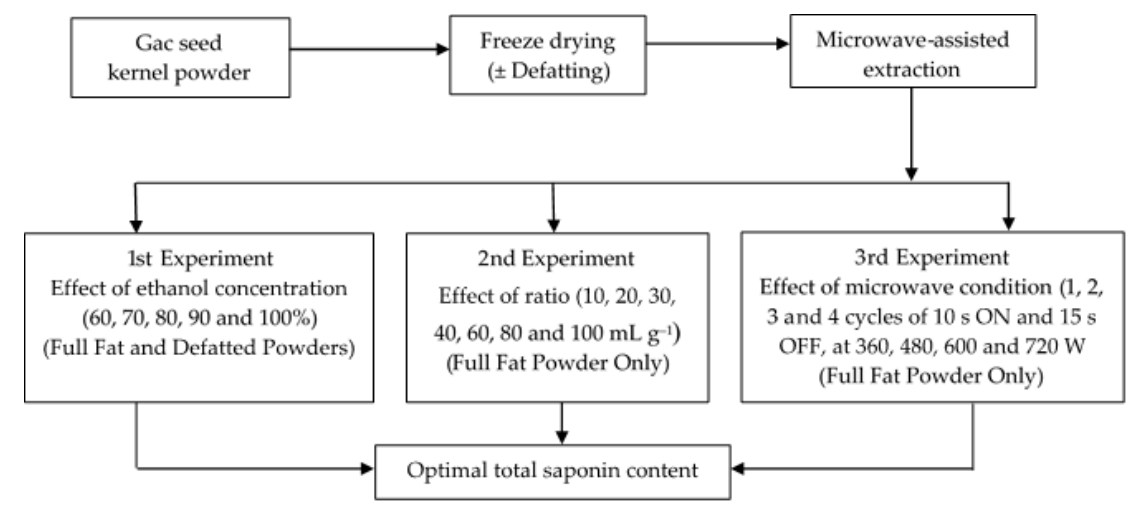
Figure 1. Experimental design for optimisation of saponin yield from Gac seeds.